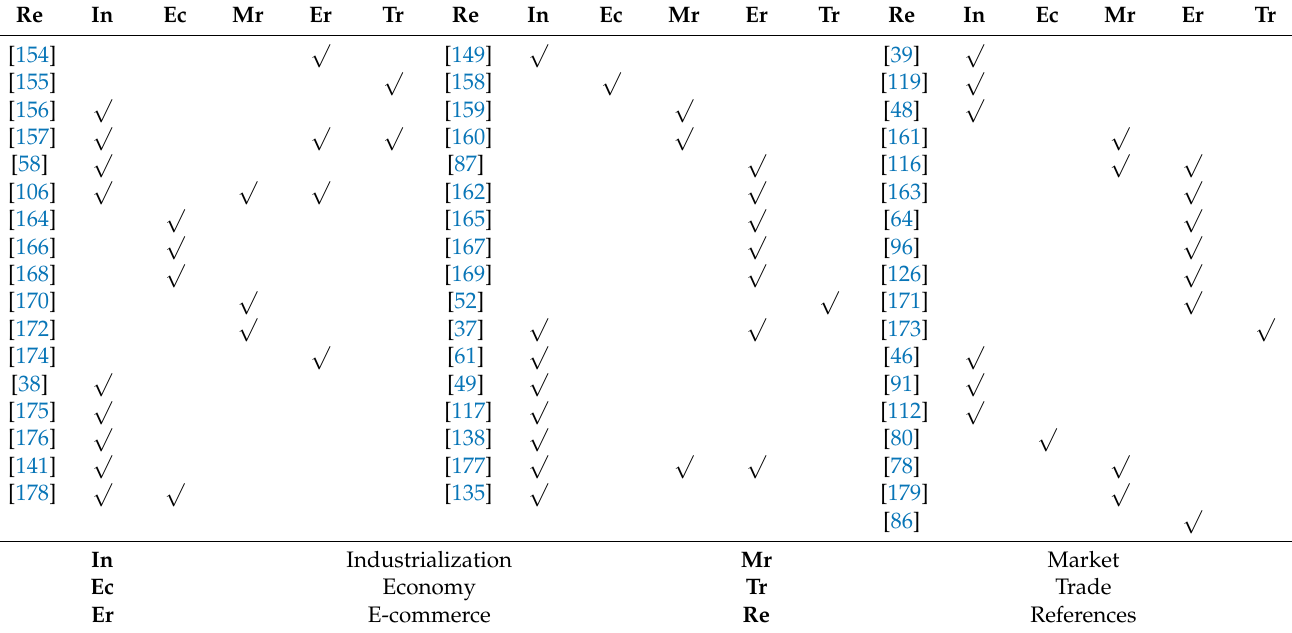
Table 7. Application of blockchain in agriculture for industrialization and